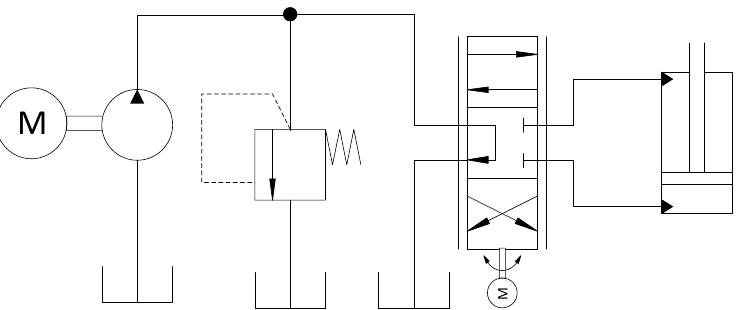
Figure 1. Schematic of a conventional small hydraulic system, including (left-right) motor, pump, relief valve, proportional directional control valve, and hydraulic cylinder.